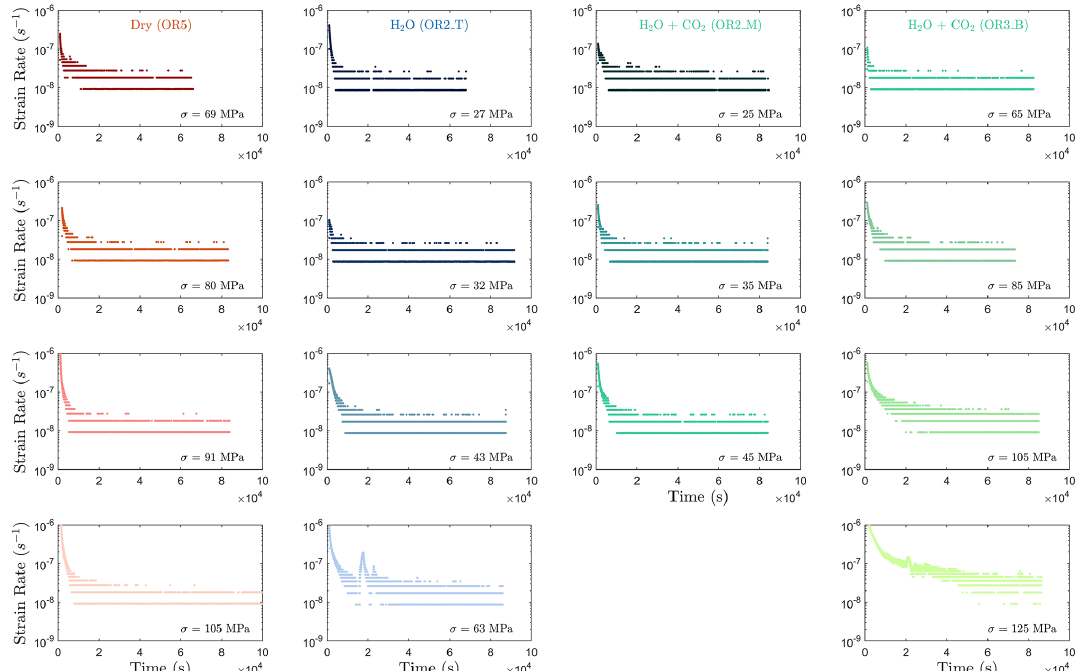
Figure A3. Strain rate evolution calculated from the first derivative of the strain vs. time data. It can be observed that the strain rates generally become constant at 10000s ( ≈ 2.8h) after the load stepping in most